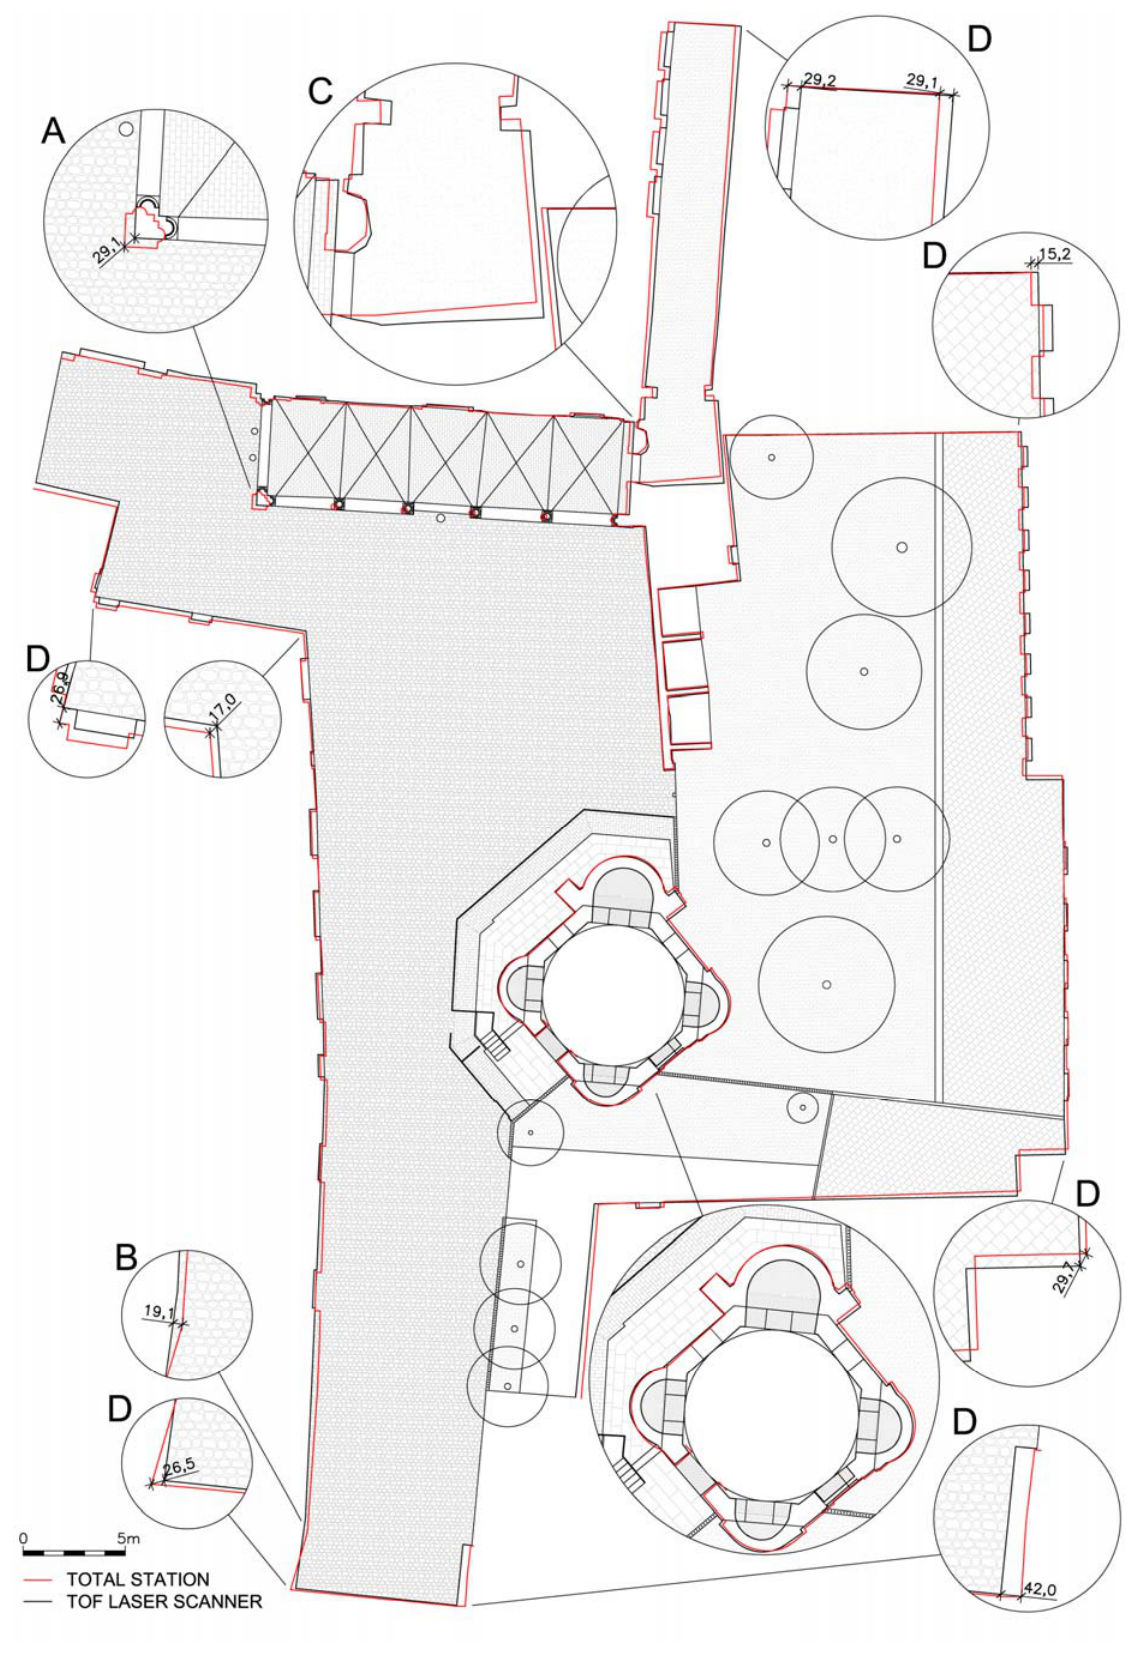
Figure 4. Comparison between the plan of Piazza degli Ariani derived from laser scanner and using a total station. The wider distances between the two point clouds can be highlighted around isolated elements (A), walls discontinuities that do not present sharp edges (B), in narrow spaces that share small contact areas with the square (C) and in peripheral areas